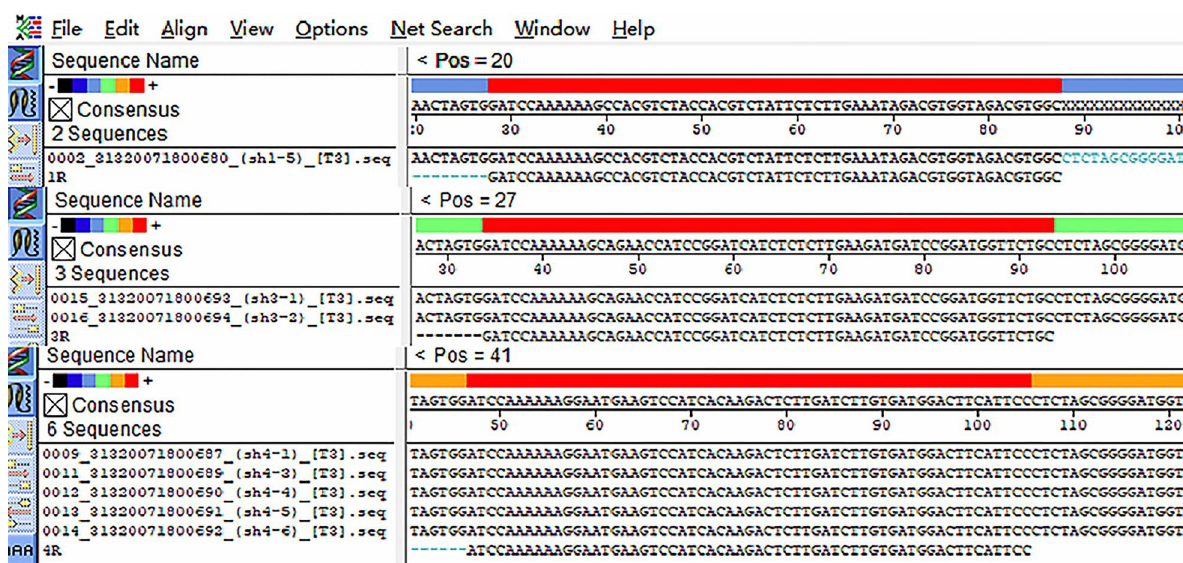
Figure 7. The pb7SK- DTX4 -shRNA interference vector was successfully constructed by annealing the DTX4 interference sequence into the pb7SK